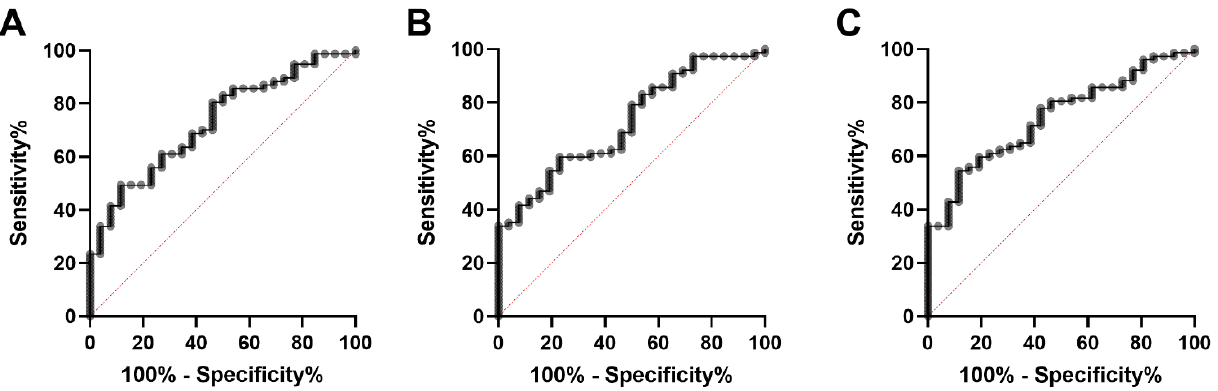
Figure 10. ROC curve analysis for discriminating non-neoplastic diseased dogs from tumour patients. ( A ) Ki-67-neutrophil ratio. ( B ) Ki-67-lymphocyte ratio. ( C ) Ki-67-monocyte ratio.